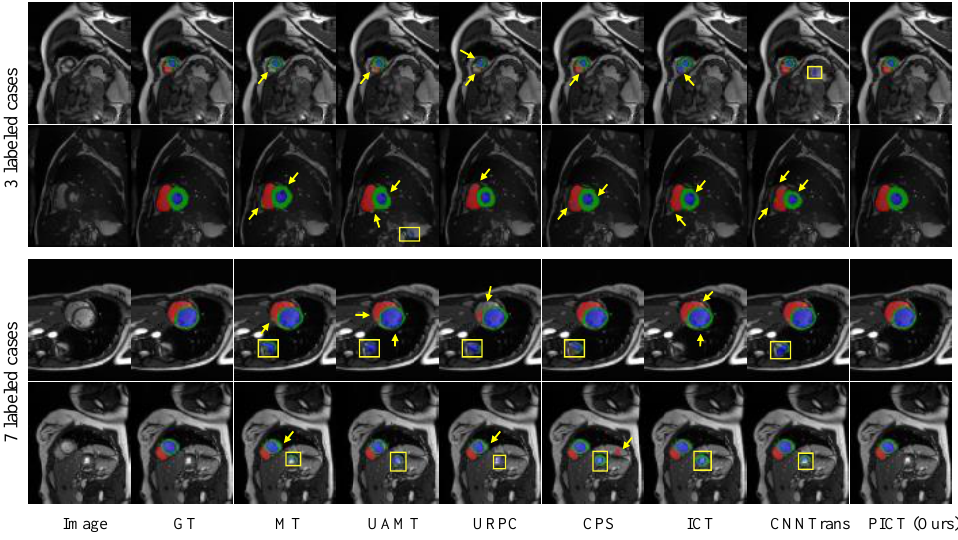
Figure 6. Visual comparison on ACDC test images of the state-of-the-art methods. The top two rows are the results of using 3 labeled cases; the bottom two rows are the results of using 7 labeled cases. The yellow arrows indicate the misclassify situation of target; the yellow boxes indicate the mispre- diction in other area.